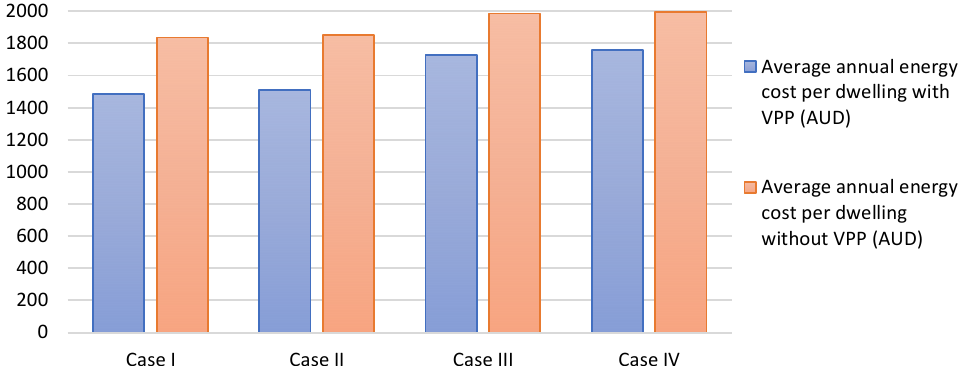
Figure 8. The average annual energy cost per dwelling with and without VPP (AUD).